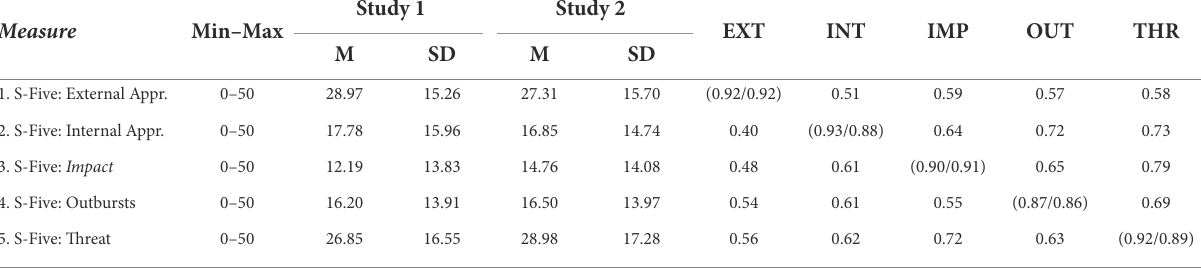
Table 3 Means and standard deviations, latent (Study 1) and Spearman’s (Study 2) intercorrelations, and reliability estimates for the